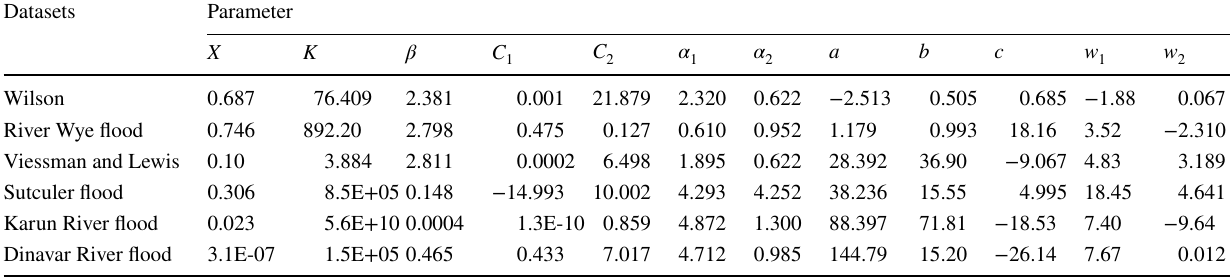
Table 7 NL5-AL model parameters for examples 1 to 6 Datasets